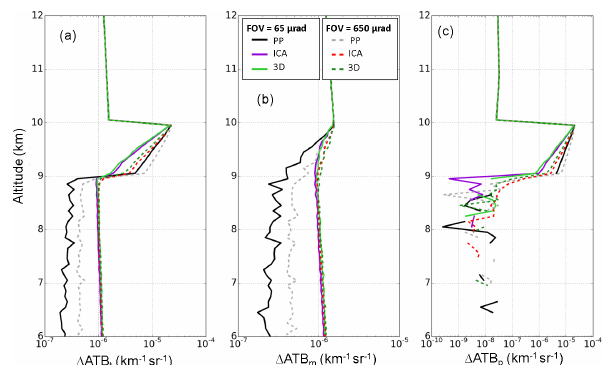
Figure 17. Same as Fig. 14 but with 50% cloud coverage. Simula- tions with ATLID FOV (65µrad) are represented by straight lines and simulations with a 650µrad FOV are represented by dotted